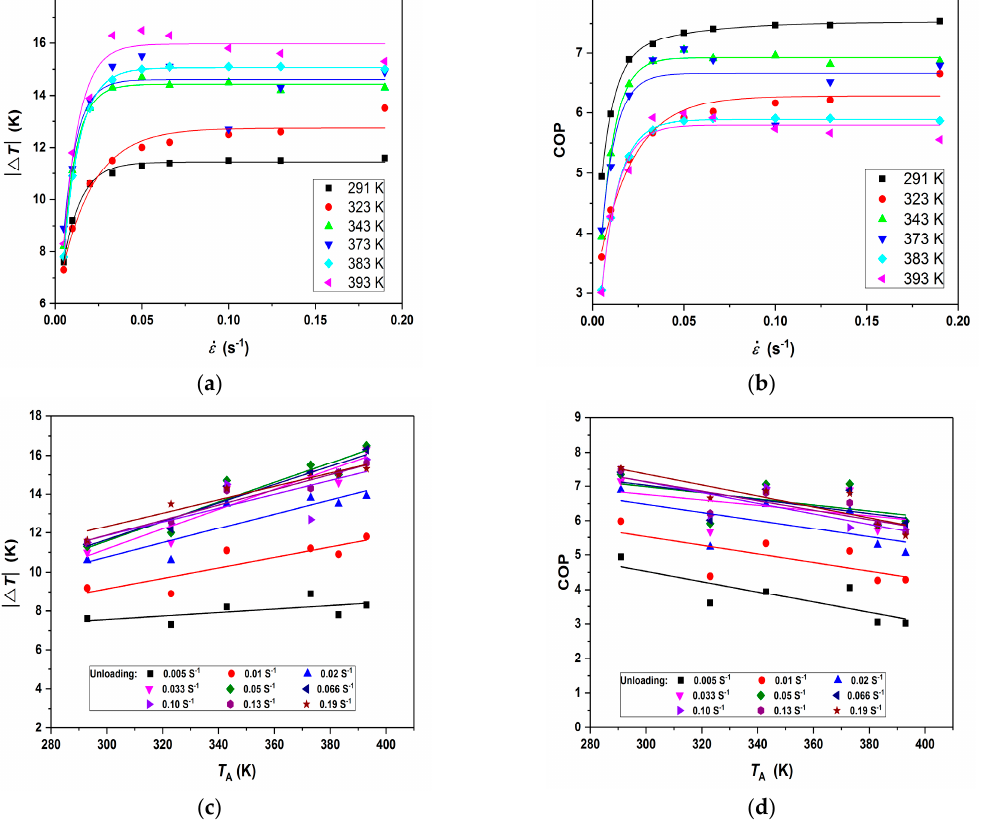
Figure 6. The | Δ T | and coefficient of performance (COP) values for unloading process in the columnar-grained Cu 71 Al 17.5 Mn 11.5 shape memory alloy (SMA) as a function of ε(cid:4662) and T A : ( a ) | Δ T | vs. ε(cid:4662) ; ( b ) COP vs. ε(cid:4662) ; ( c ) | Δ T | vs. T A ; ( d ) COP vs. T A .